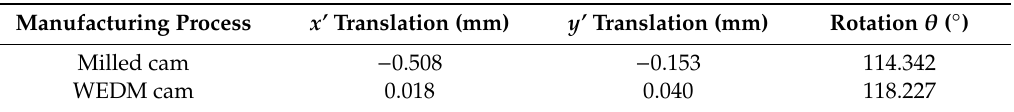
Table 4. Values of x ’ translation, y ’ translation, and rotation that must be applied in order to minimize the square of the distance between theoretical and manufactured profiles.